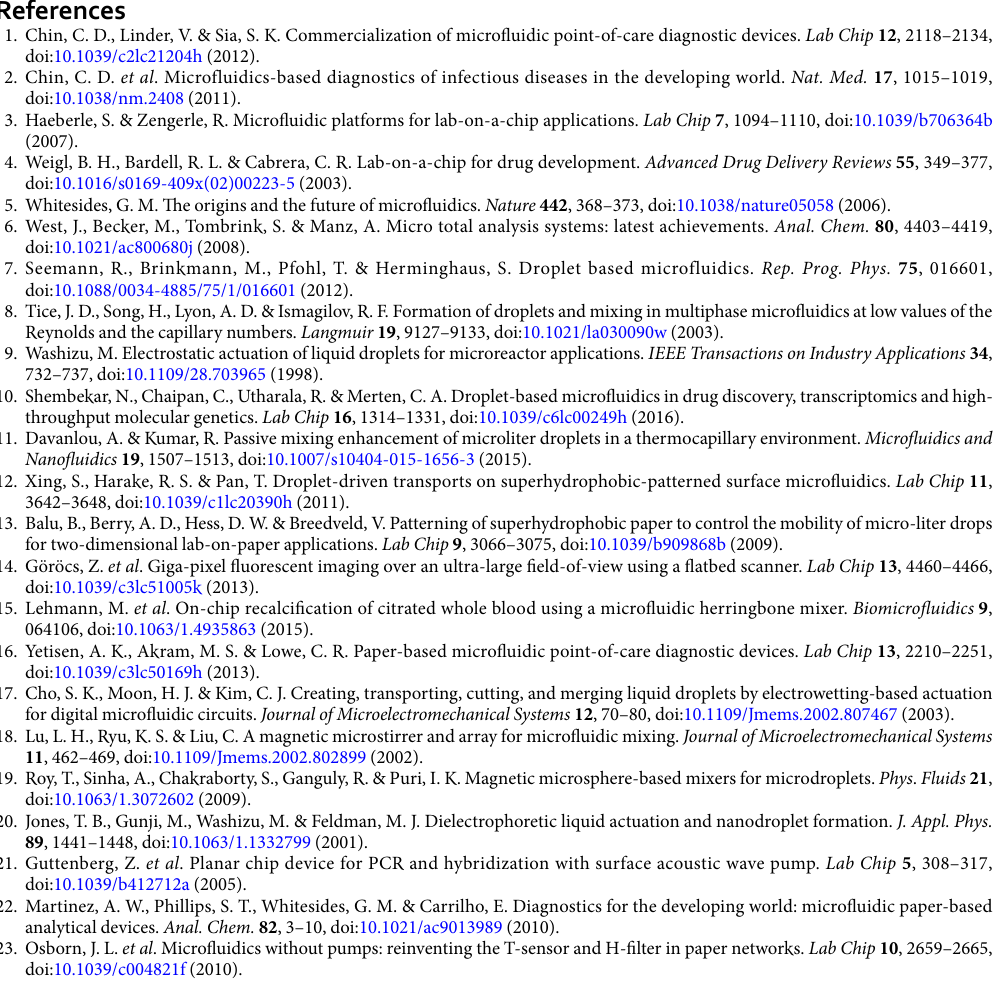
where N δ is the number of pixels along the track width ( δ w ). The degree of mixing homogeneity ( σ k ) and the mix- ing efficiency ( η k ) for a given location ( x ) and time ( k ) was ultimately calculated by